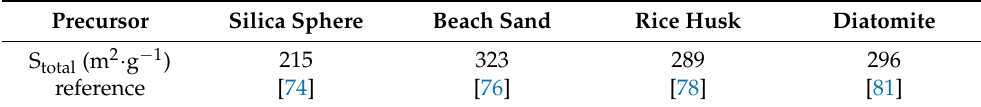
Table 1. Specific surfaces area of porous Si from different silicon